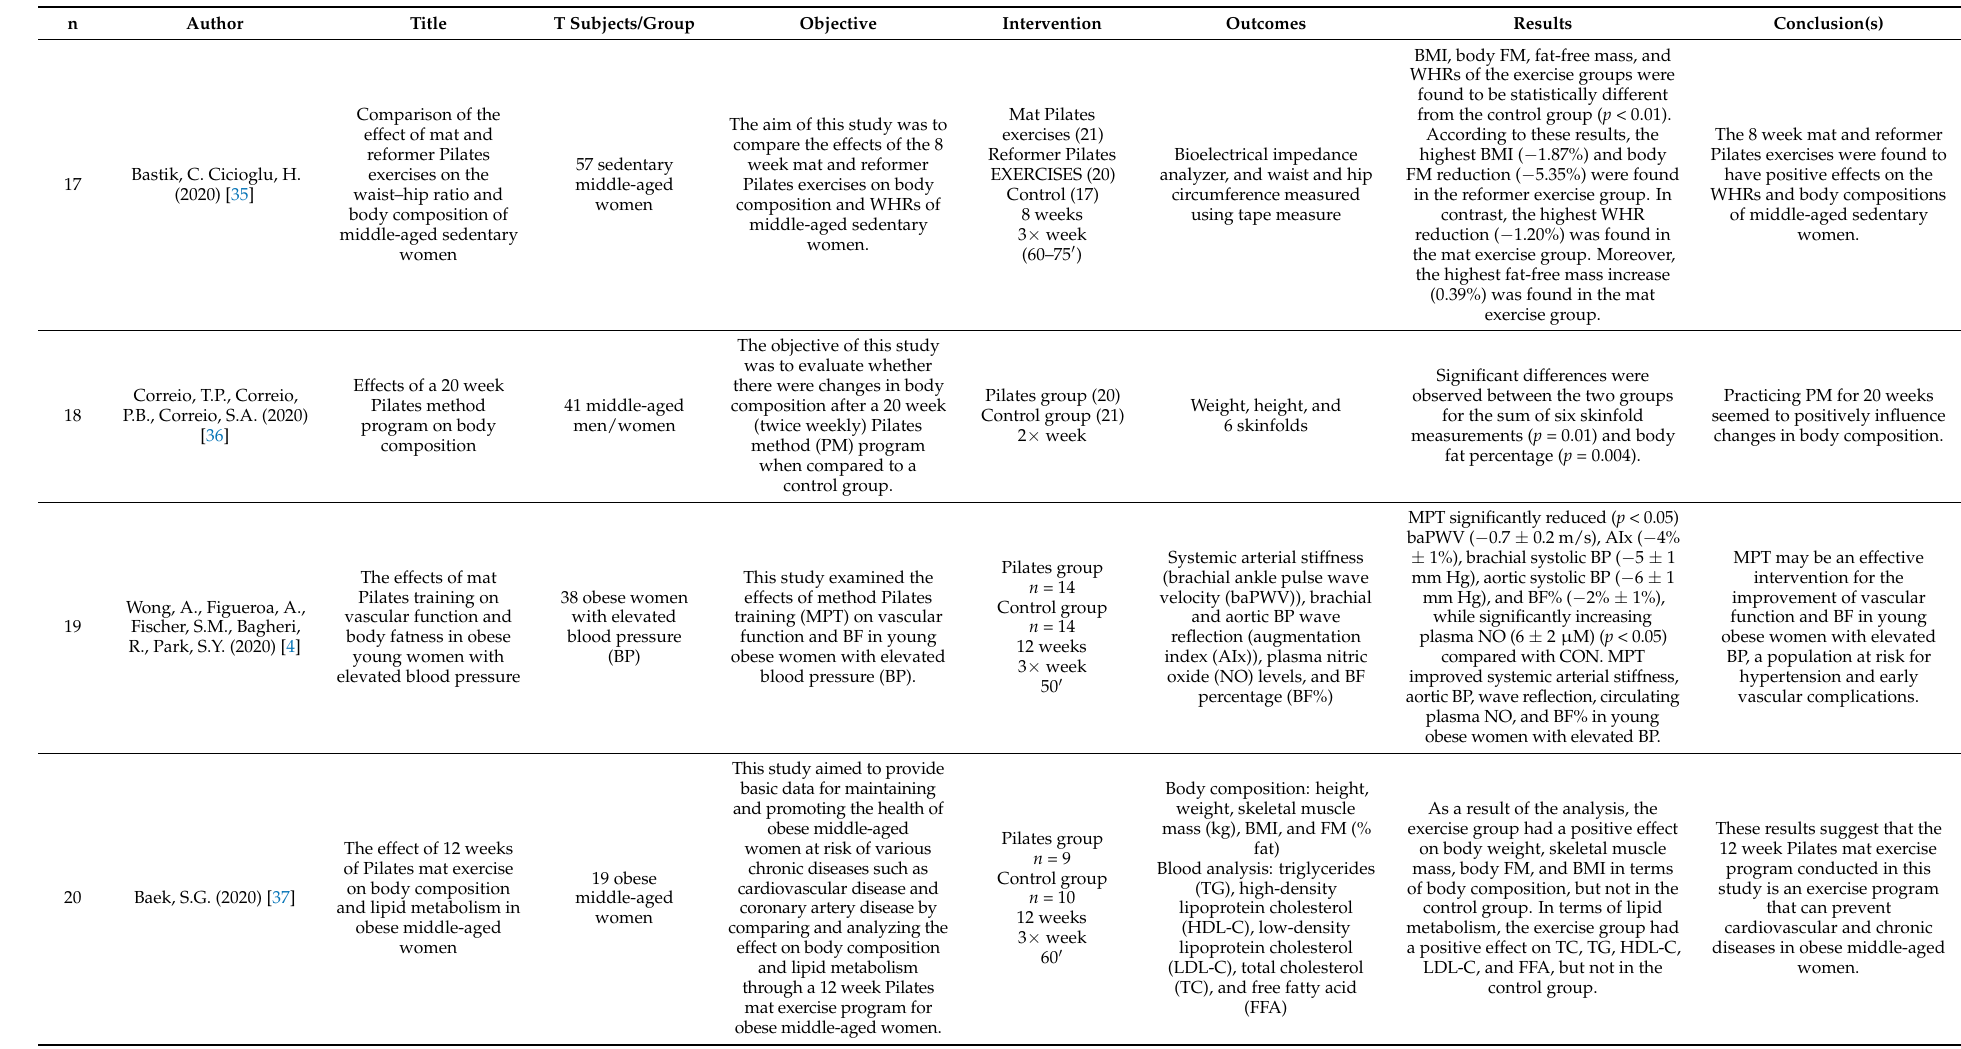
Body composition: height, weight, skeletal muscle mass (kg), BMI, and FM (% fat) Blood analysis: triglycerides (TG),